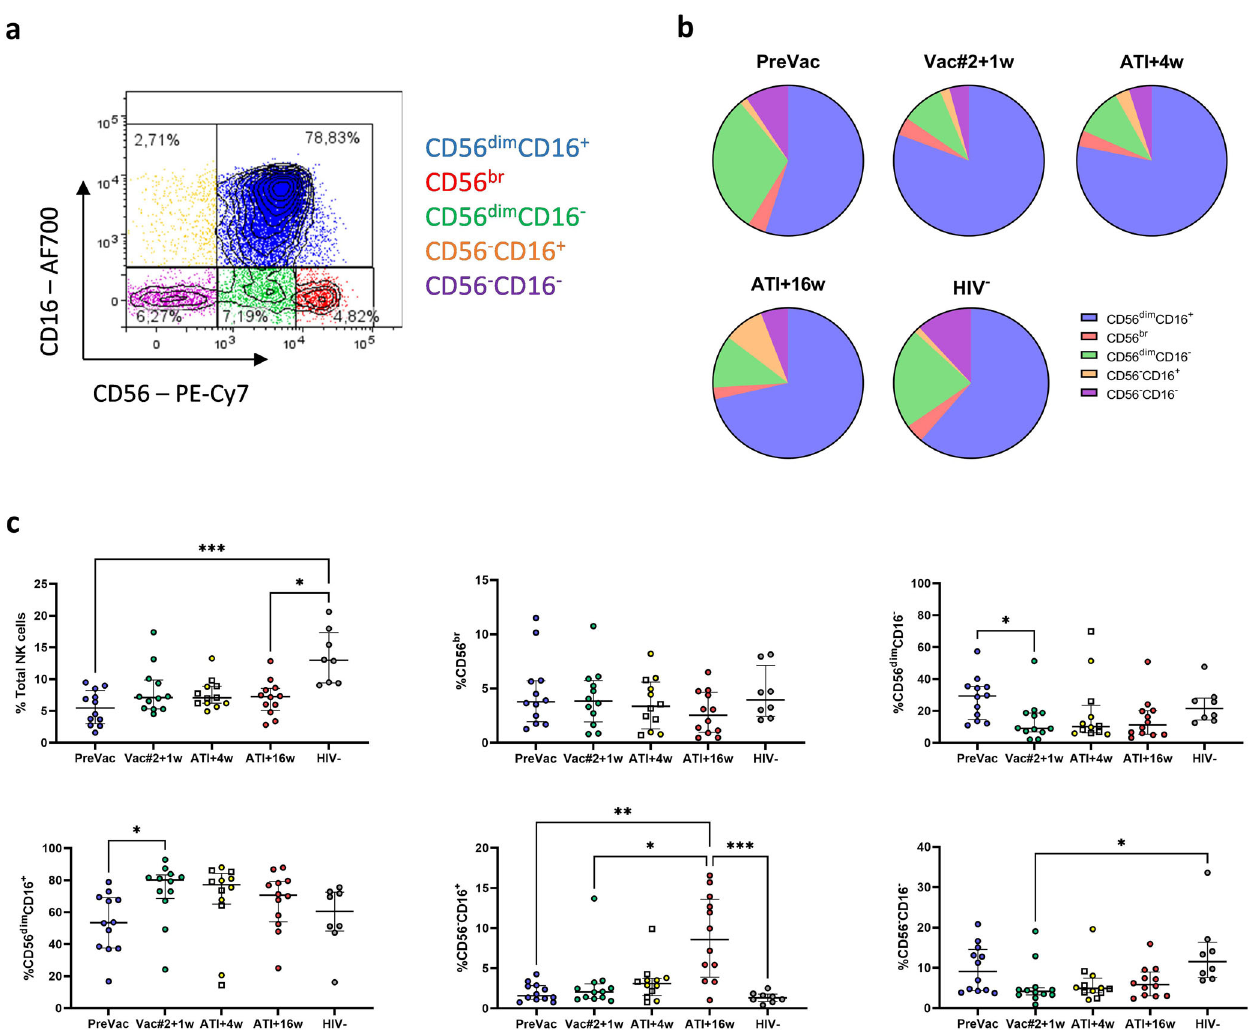
Fig. 2 Frequency of NK cell subsets during the course of the DC-TRN trial. a Gating strategy used to identify different subsets of human NK cells based on CD56 and CD16 expression. b Pie charts showing the proportional distribution of the various NK cell subsets. c Frequency of total NK cells and NK cell subsets in blood during the course of the DC-TRN study ( n = 12) and in HIV-1 − individuals ( n = 8). Participants who rebounded at ATI + 4w are indicated with squares. Data are presented as median ± interquartile range (IQR), Kruskal – Wallis test with Dunn ’ s multiple comparisons test for post-hoc analysis. P -values <0.05 were considered statistically signi fi cant and graphically denoted as follows: * p < 0.05, ** p < 0.005 and *** p <